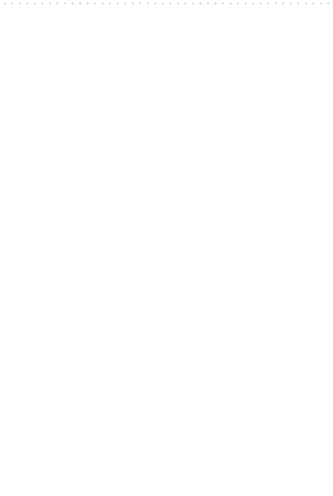
Table 4. Full-scale EN-MBBR system design parameters proposed for GPS-X7